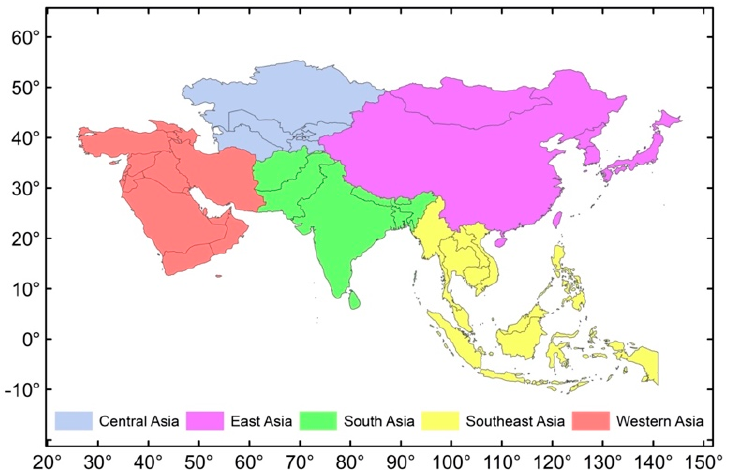
Figure 1. Regional division of Asia